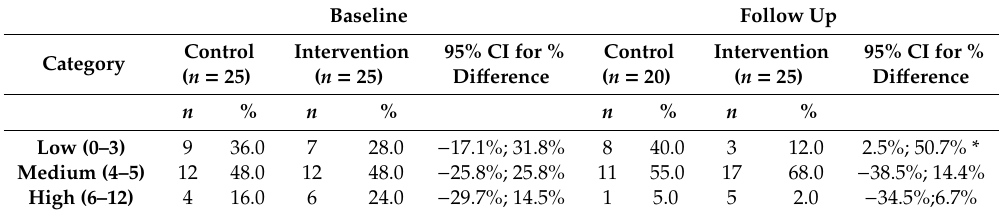
Household Dietary Diversity Scores of control and intervention groups at baseline and